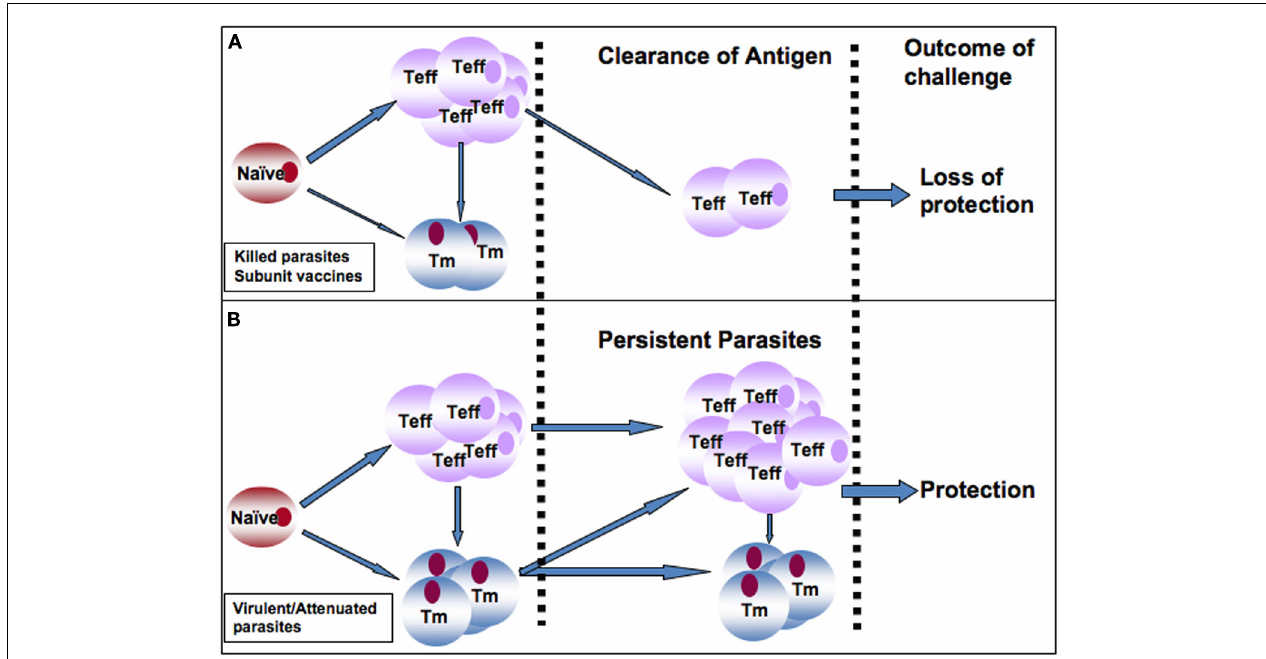
to secondary virulent challenge. (B) In contrast, infection with virulent parasites or vaccination with live-attenuated or genetically modified parasites leads to generation of robust and balancedTeff andTm cells, infection-induced immunity, and persistence of low number of parasites at the infection site and its draining lymph node. Persistent parasites promote constant generation and maintenance ofTeff andTm cells in the draining lymph node leading to maintenance of immunity and protection against secondary virulent challenges.This would eliminate the need for frequent booster